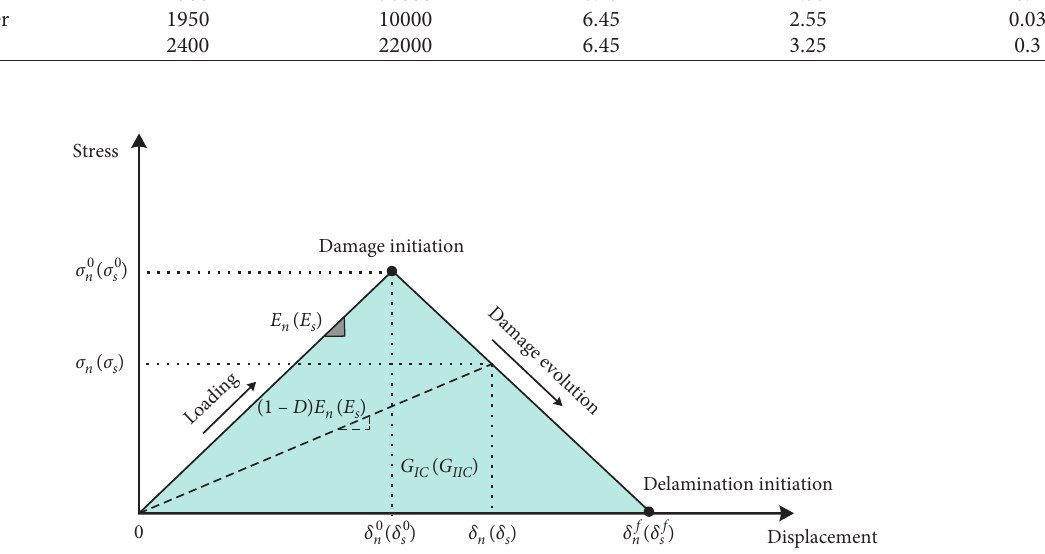
Figure 5: The bilinear stress-displacement relationship for the